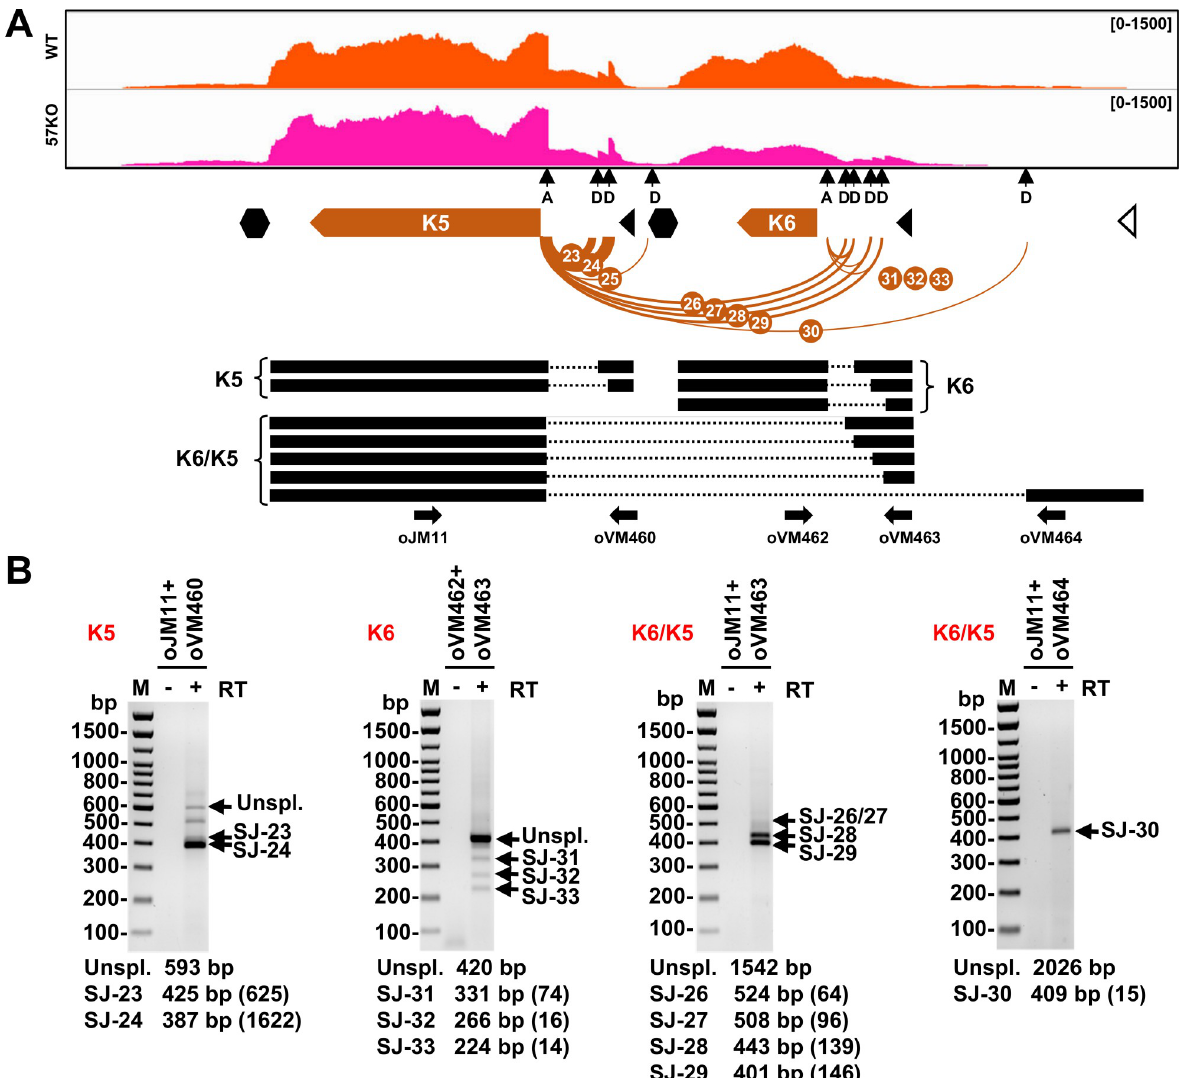
Fig 5. Alternative RNA splicing detected and verified from the K5/K6 locus. (A) The RNA splice junctions mapped to K5 and K6 locus in the WT genome. Below is the predicted structure of K5, K6, and K6/K5 transcripts with thick black lines representing the exons and dotted lines the introns. The arrows represent the primers used in RT-PCR shown in (B). See other details in Fig 3 . (B) Verification of the mapped RNA splice junctions in K5/K6 expression in BCBL-1 cells with lytic KSHV infection. Total RNA extracted from the parental BCBL-1 cells with VA 24 h treatment was examined by RT-PCR. The reaction without reverse transcriptase (RT-) was used as a negative control. The predicted sizes of amplificons from unspliced and spliced transcripts are displayed under each gel electrograph. All spliced products amplified were gel purified and confirmed by sequencing. The number of supporting splice reads from the WT genome in the cells with lytic KSHV induction are in the parentheses.